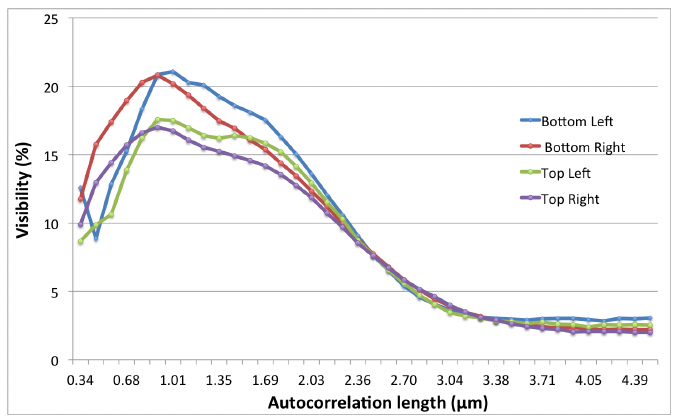
Figure 3. Interferometer visibility measured at the four corners of the sample